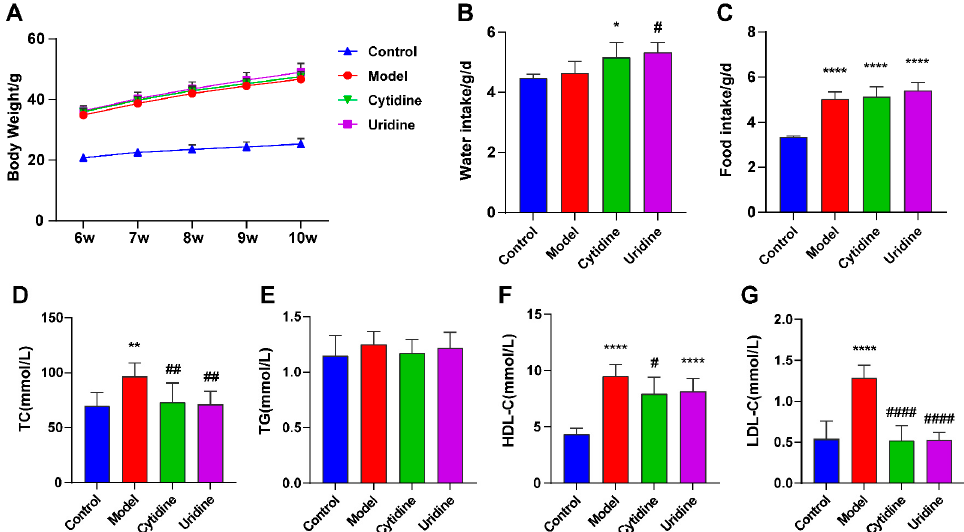
Figure 1. Effect of cytidine on body weight ( A ), water intake ( B ), food intake ( C ), serum total cholesterol (TC) ( D ), total triglyceride (TG) ( E ), high-density lipoprotein cholesterol (HDL-C) and ( F ) low-density lipoprotein cholesterol (LDL-C) ( G ) levels in ob/ob mice. Data are expressed as mean ± SD (n = 8). * p < 0.05, ** p < 0.01, **** p < 0.0001 compared with control group; # p < 0.05, ## p < 0.01, #### p < 0.0001 compared with model group.